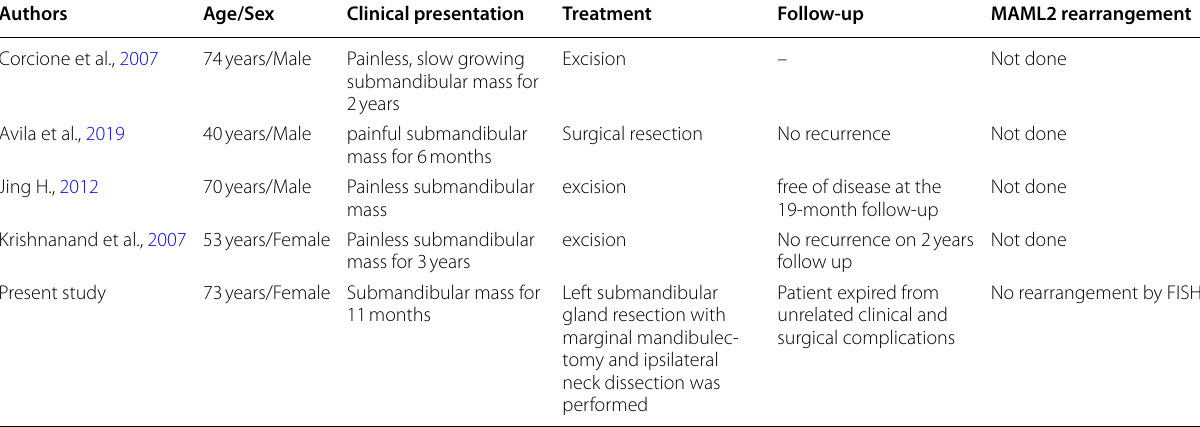
Table 1 Cases of submandibular OMEC reported in English